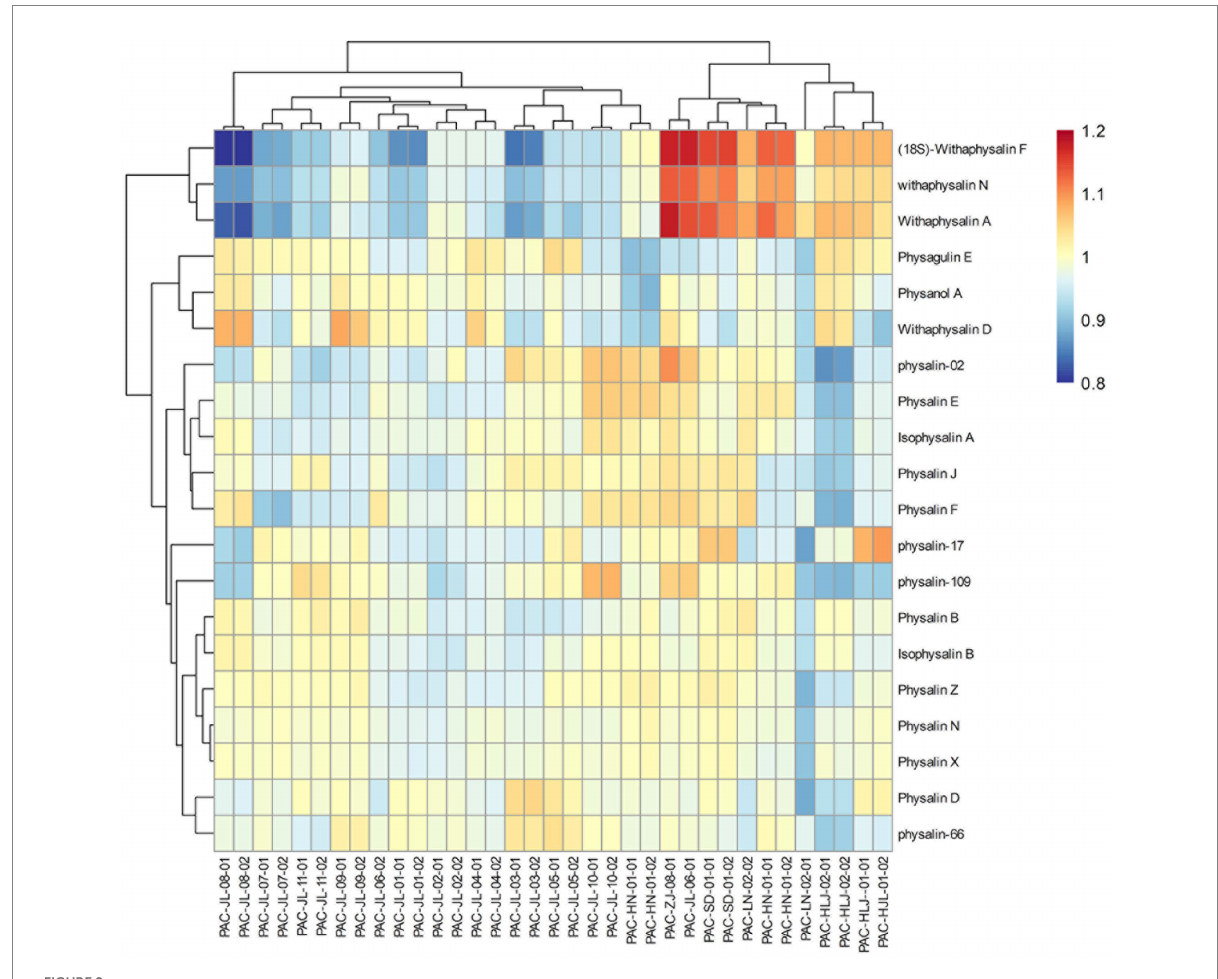
FIGURE 9 Heatmaps of physalin metabolites in geographically diverse calyxes of P. alkekengi